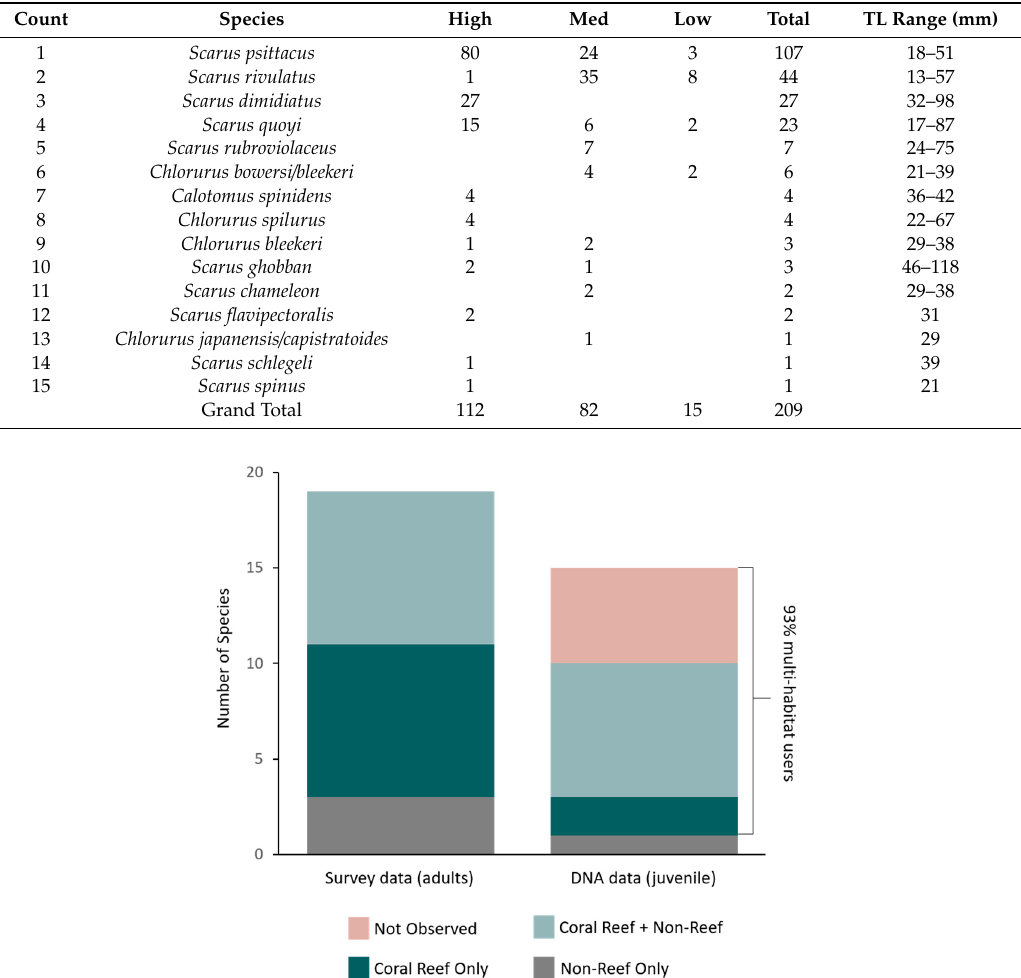
Table 3. Juvenile parrotfish collections and confidence associated with species identification accuracy: Total length (TL) range is the minimum and maximum TLs for each species.